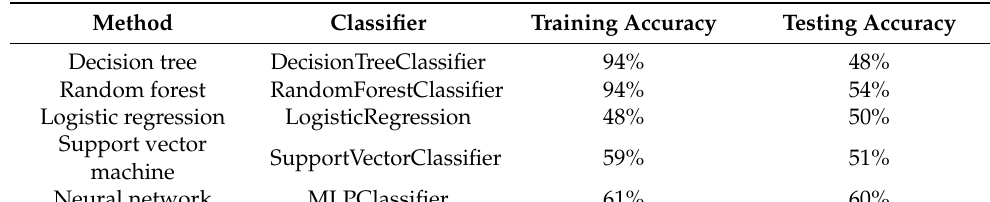
Table 3. Comparison of ML prediction method.